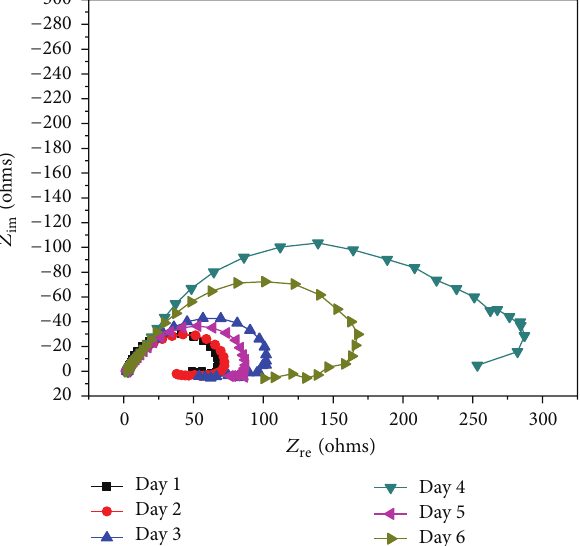
Figure 7: Nyquist plot for pipeline steel in 0.5 M H 2 SO 4 with and withoutdifferentconcentrationsof Brassicaoleracea extractat323K.